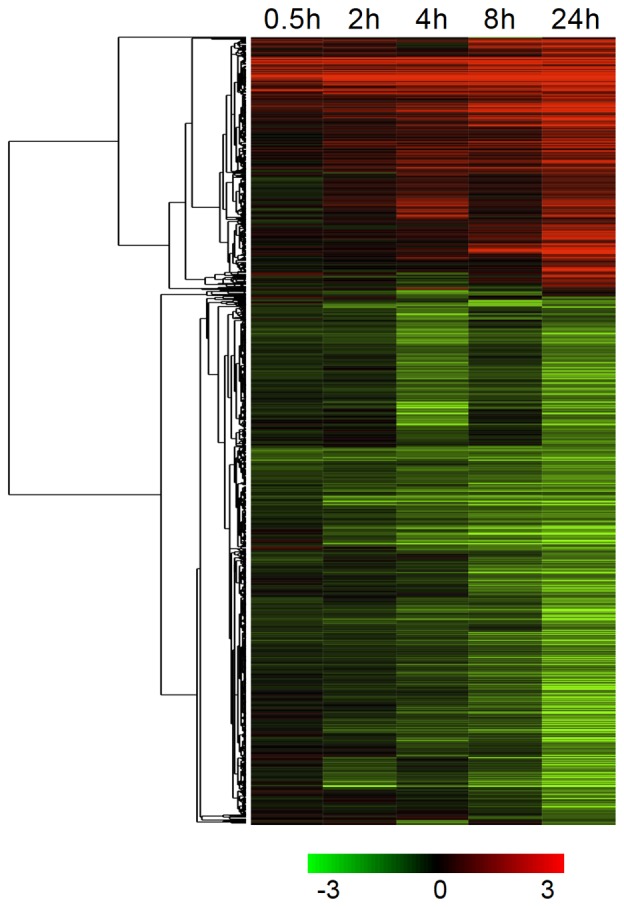
Hierarchical clustering of JM genes significantly differentially expressed in at least one time point under cold stress.Clustering was performed with Cluster 3.0, using the average linkage method and Pearson correlation as similarity measure. The tree was generated with Java TreeView 1.1.6. Red: up-regulated genes; green: down-regulated genes. Log2 transformed fold change expression levels are indicated by the color gradient. The extreme values in the color gradient are −3 to +3 in log2 scale.